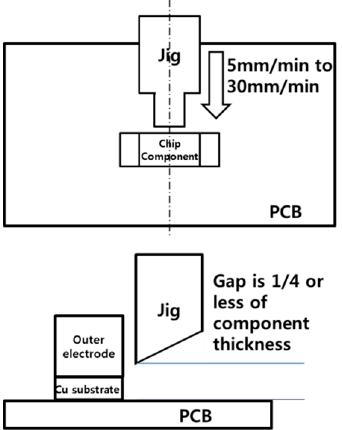
Figure 2. Schematic diagram of the shear testing.